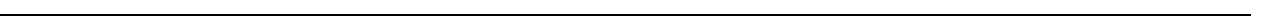
Table 3: GLM-2, contrast 1); it extended from the medial orbital sulcus across the gyrus rectus (possibly areas 14r and 11m 26 ;